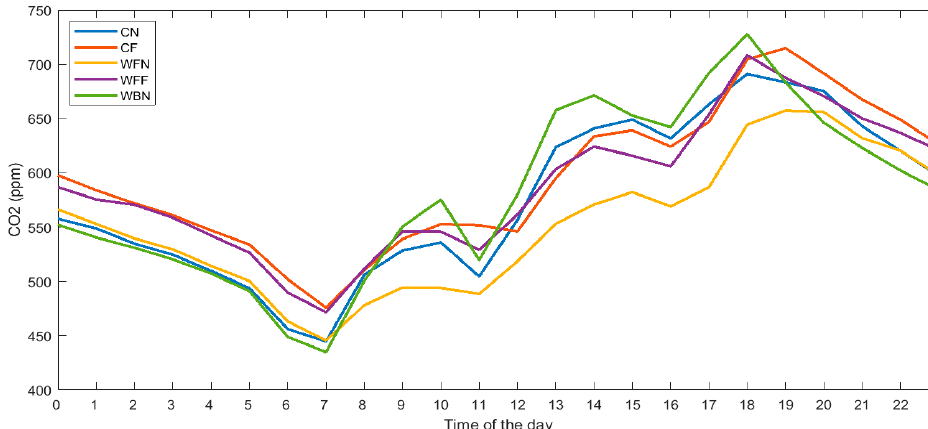
Figure 11. Time series of CO 2 sensors in various positionings.